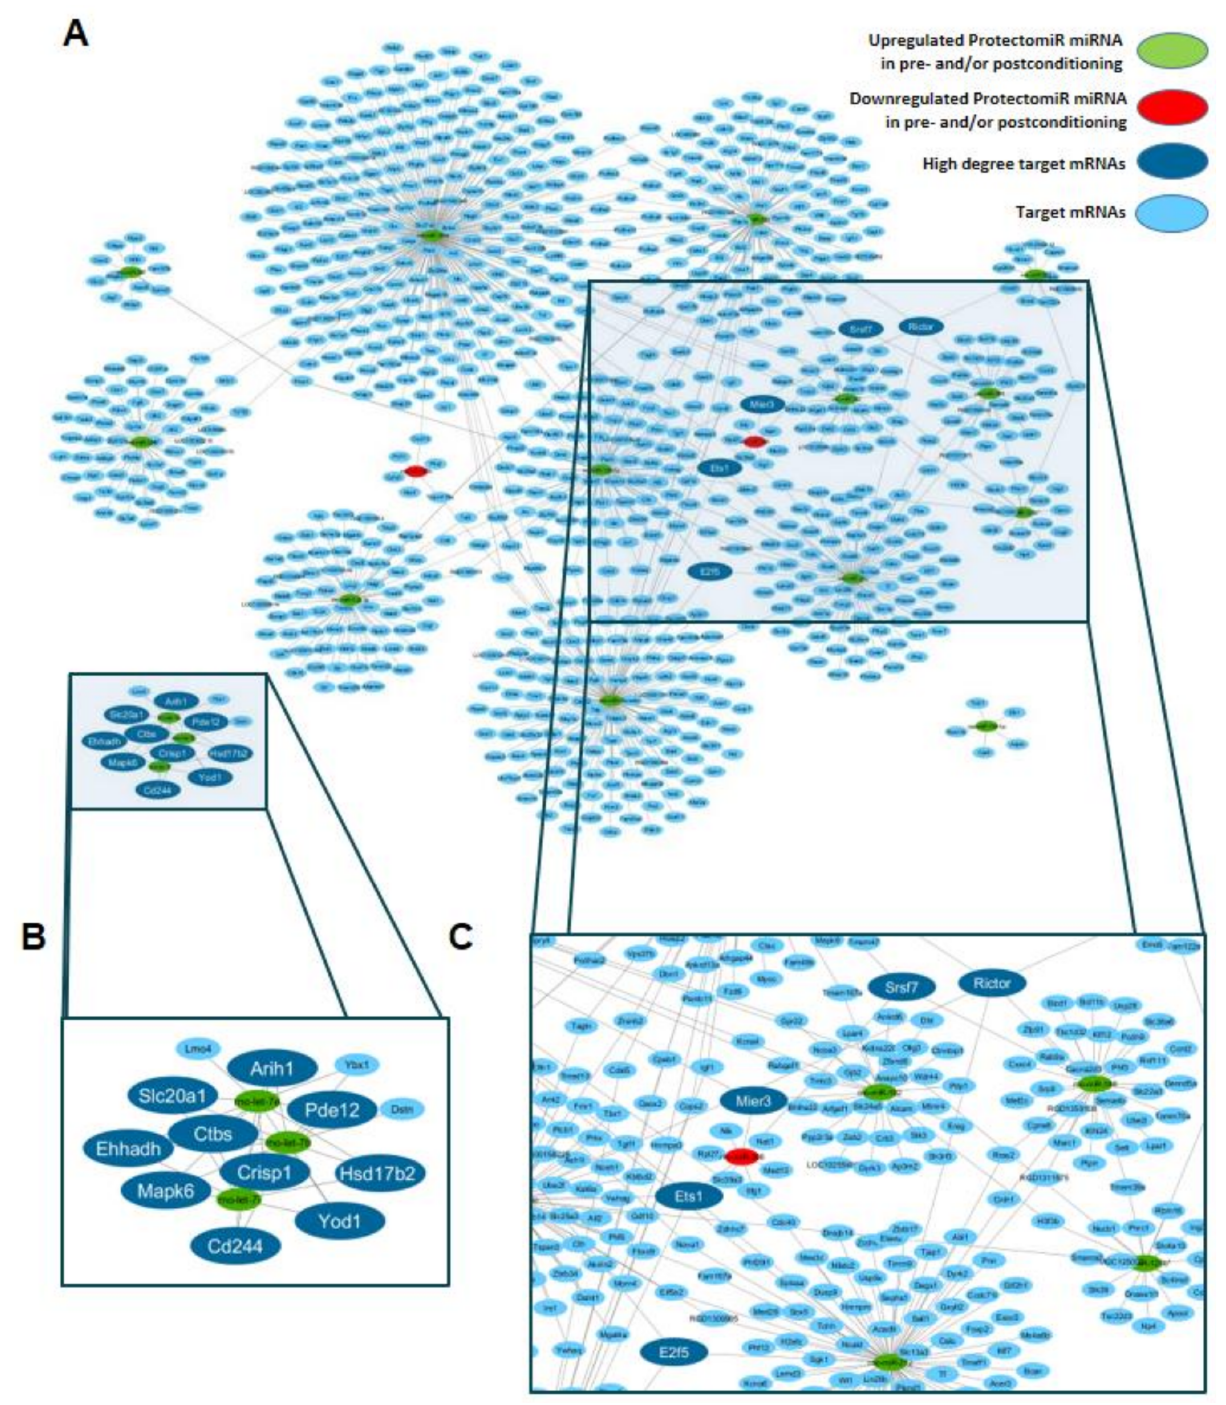
Figure 2. Predicted interaction network of ProtectomiR microRNAs ( A ) showing the network neighborhood of predicted hub genes with at least three microRNA–mRNA target interactions (node degree) ( B , C ). Panel (C) shows the role of the most central target hub Rictor . MicroRNAs upregulated and downregulated in pre- and/or postconditioning and target mRNAs are indicated in green, red and blue, respectively. Dark blue nodes represent mRNAs with a node degree of at least 3. A high-resolution version of the network is available as Supplementary Figure